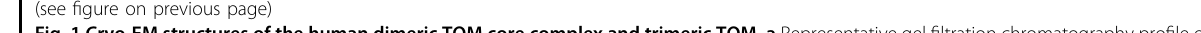
(Fig. 1c). Two Tom40s, as elliptical barrels, were tilted and located close to each other. Two Tom22s were embedded in the symmetry plane of the entire structure to bridge two Tom40s. Small Tom proteins closely surrounded Tom40.